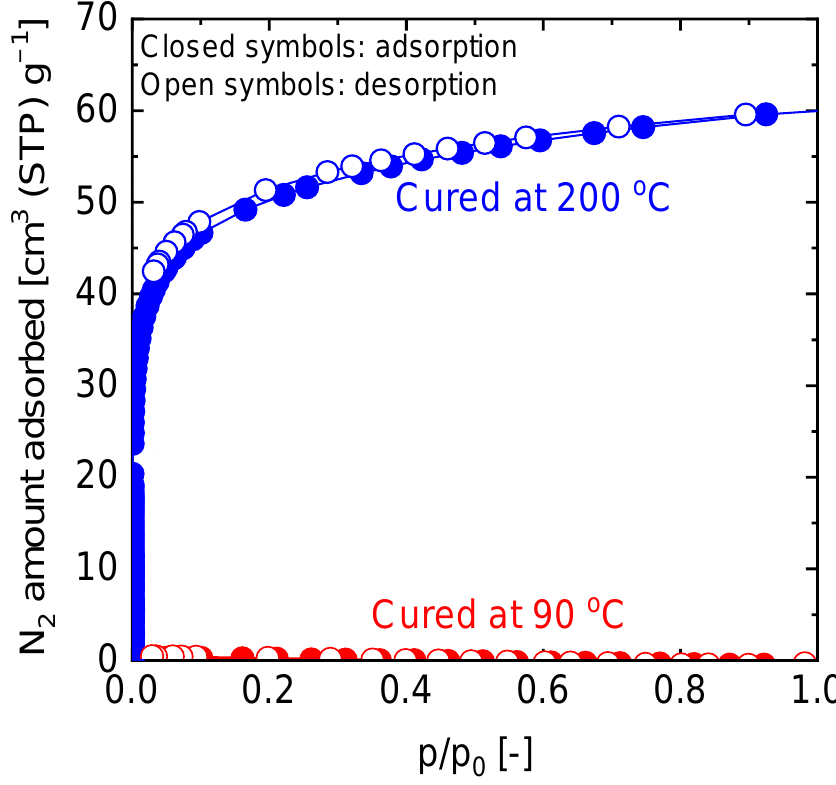
Figure 23. Nitrogen adsorption and desorption isotherms at 77 K of carbon-SiO 2 -ZrO 2 powders derived from 90 °C- and 200 °C-cured SiO 2 -ZrO 2 -polybenzoxazine resins after pyrolysis at 750 °C. Adapted from [110,111].